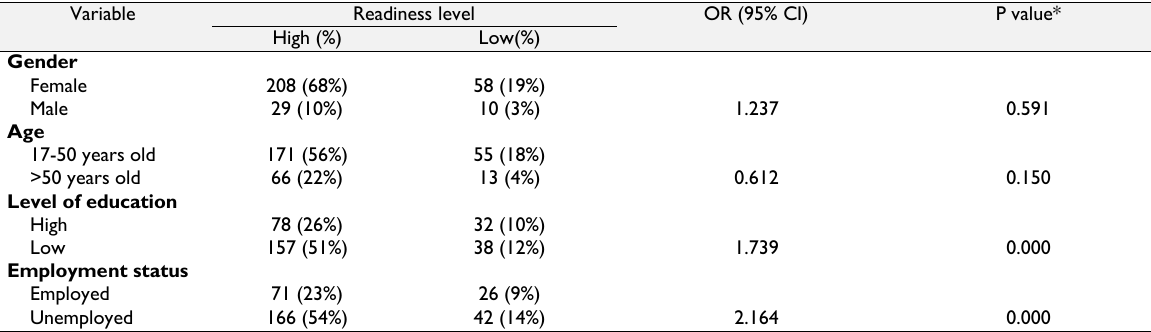
Table 2 Relationship between characteristics of the respondents and readiness level